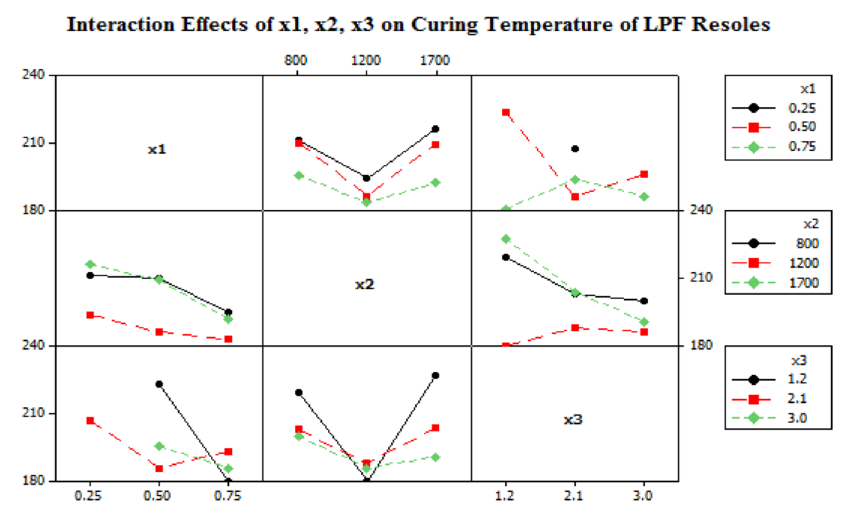
Figure 9. Interaction effects on curing temperature of BPF resoles.